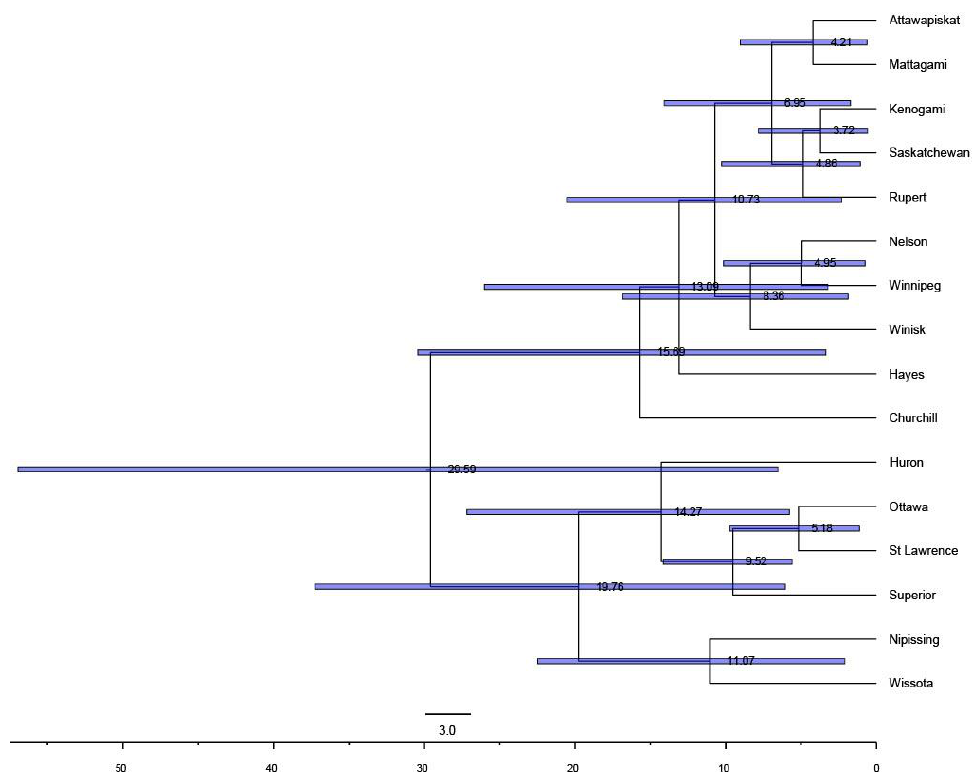
Figure 5. Estimated phylogenetic relationships and divergence times in thousands of years between the major intraspecific lineages of lake sturgeon and geographically representative populations within each lineage based on coalescent analysis, with the horizontal axis showing estimated time for most recent common ancestry (T MRCA ) in thousands of years. Shaded horizontal bars on each branch node represent 95% confidence intervals for estimated divergence times.